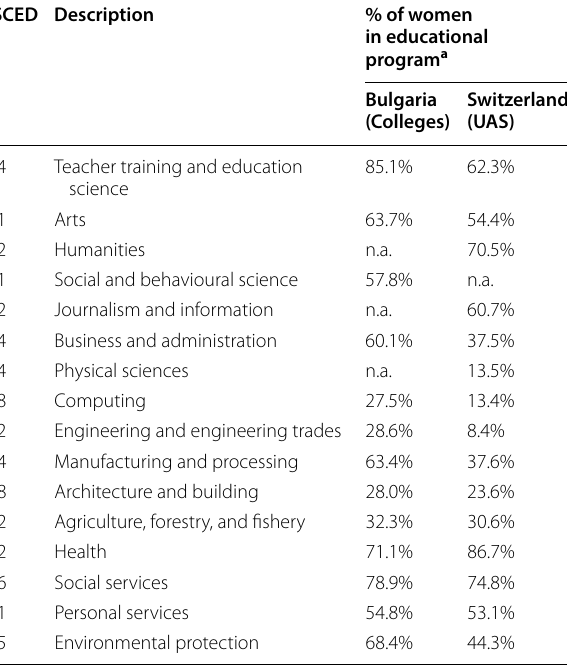
Table 12 Classification of educational programs